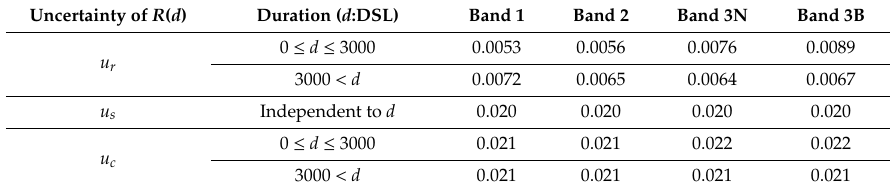
Table A1. The uncertainties of R ( d ) calculated from the multiple field data for ASTER VNIR bands. Uncertainty of R ( d )